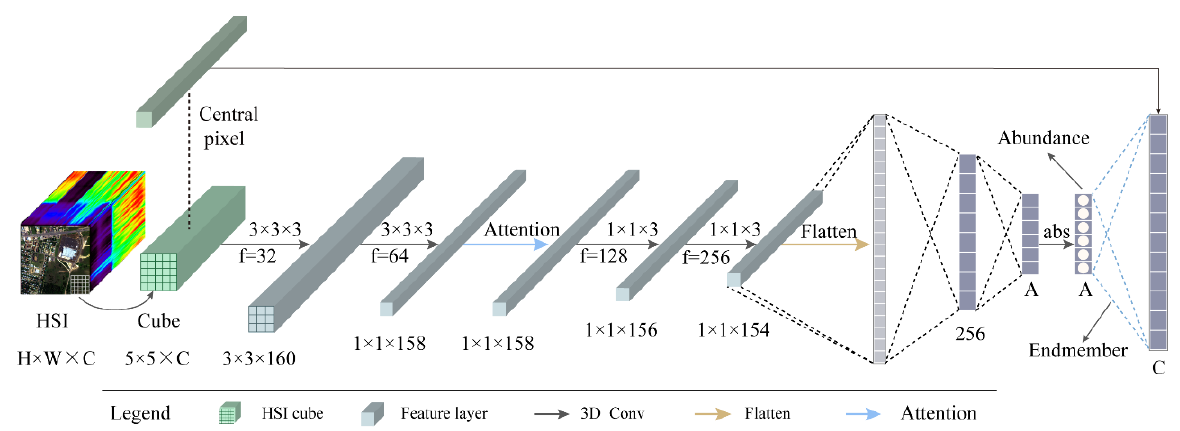
Figure 1. Diagram of the proposed 3D convolutional neural network. Table 1. The structure of the CACAE model.